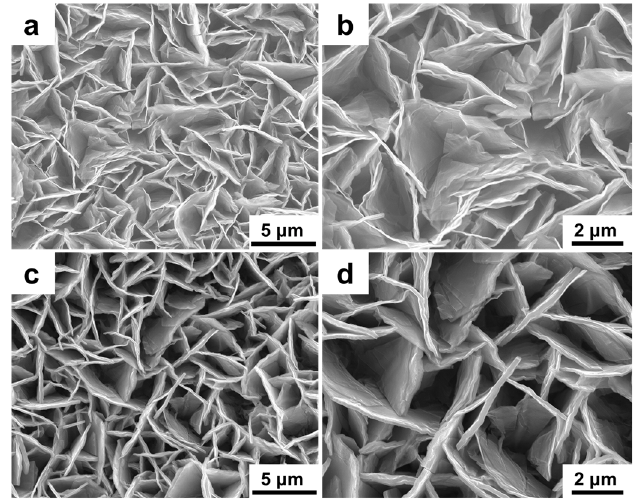
Figure 10. FESEM micrographs of ( a , b ) CoAl LDH and ( c , d ) CoAl LDH-PANI obtained by 6000 GCD